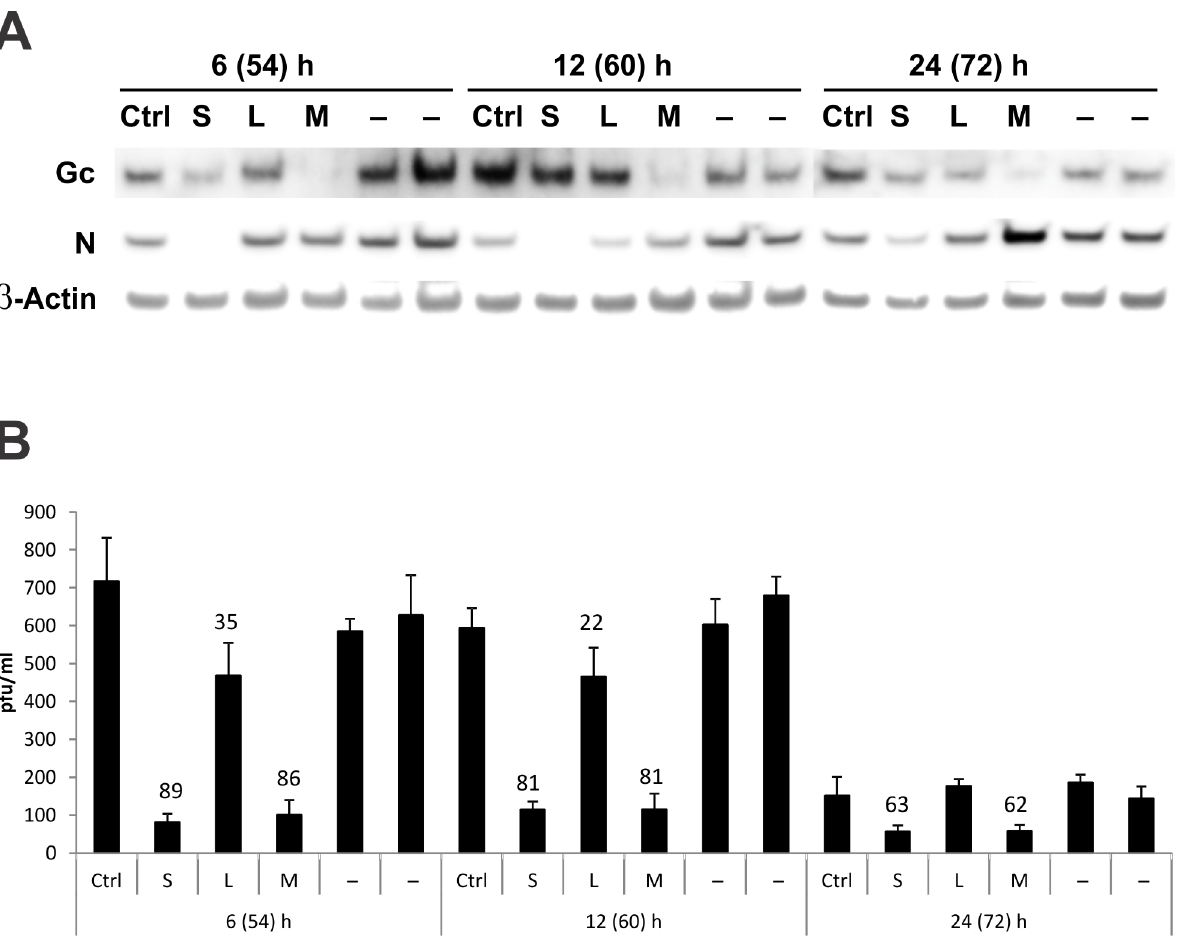
Figure 5. siRNA administered to HMVEC-L post-infection inhibits ANDV replication and infectious virus release. Cells were infected with ANDV at MOI =0.5. After virus adsorption for 2 h, the virus inoculum was removed and replaced with fresh media. The cells were then transfected 6, 12, or 24 h post-infection with 100 nM of siS, siL, or siM using DharmaFECT 1. Time shown in parentheses indicates total h post- infection. (A) Viral protein levels as determined by Western blotting. (B) Viral release as determined by immunofocus assays. All experiments were performed in triplicate. Data shown above each bar indicates percent decrease in comparison to the scrambled siRNA control.